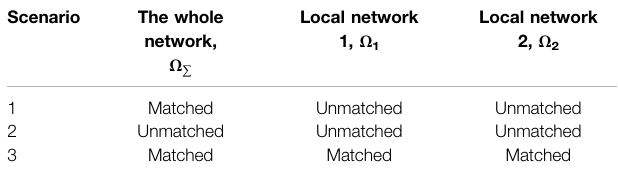
TABLE 1 | Three typical scenarios of case